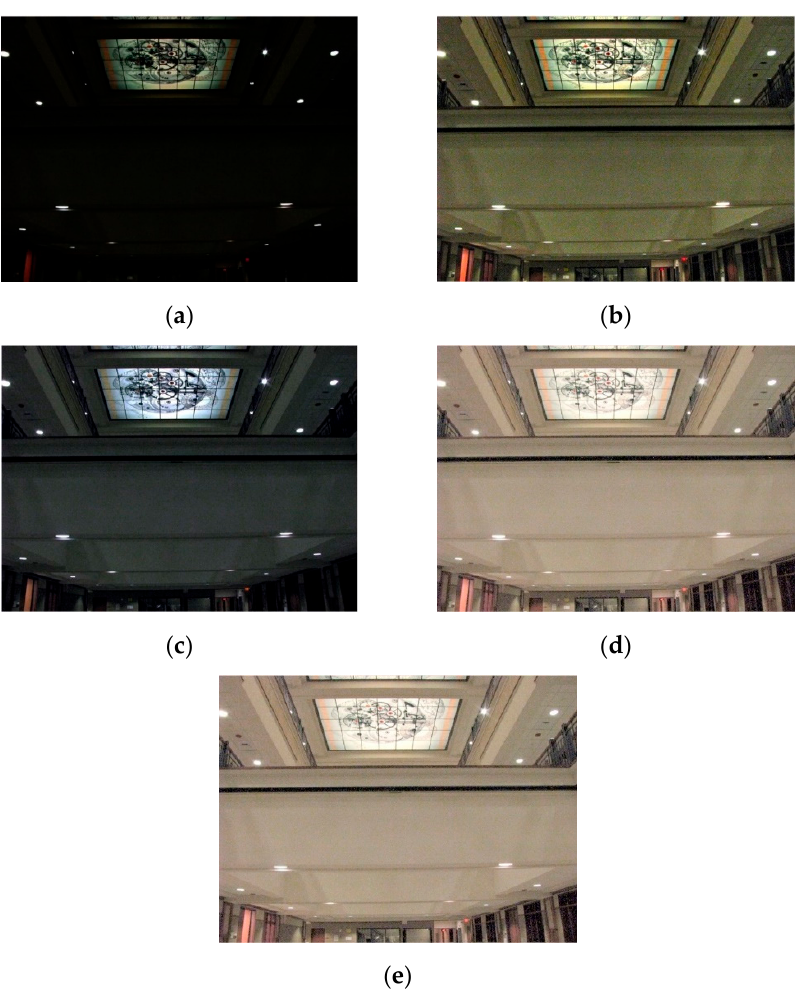
Figure 5. “aligned_00165” images with ( a ) an original HDRI, and resulting images of ( b ) iCAM06, ( c ) Reinhard’s method, ( d ) Choi’s method, and ( e ) the proposed method. Table 1. Comparative evaluation of computational cost between iCAM06, Reinhard’s method, Choi’s method, and the proposed method (units: per seconds).